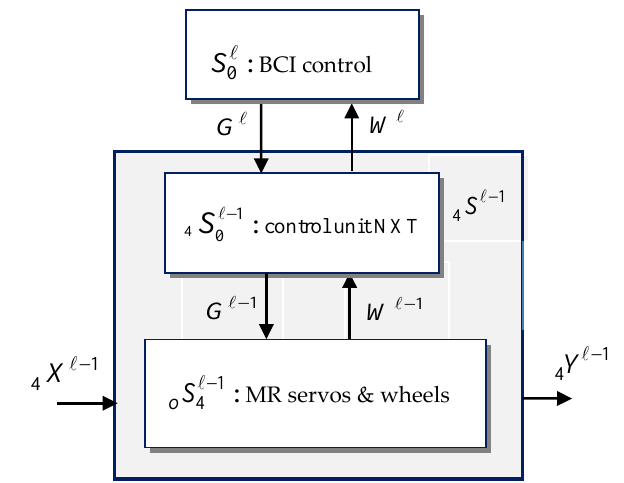
−  S  and NXT control unit o S (cid:96) − 1 presented in form of coordinators of 4 S (cid:96) − 1 S and NXT control unit 1 o presented in form of coordinators of 0 4 0 4 o S 4 of level ℓ −1, i.e., servos and wheels, respectively.